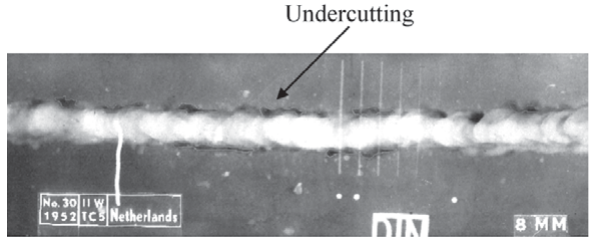
Figure 2. Identification of defects on the